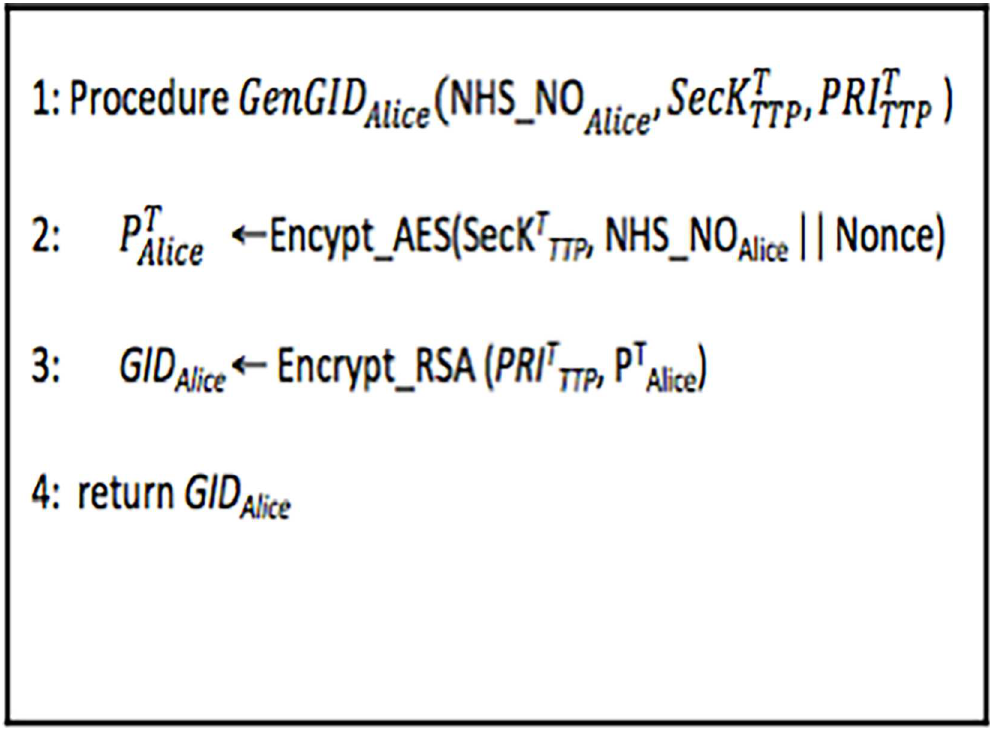
Fig 1. Algorithm 1: Generation of GID Alice